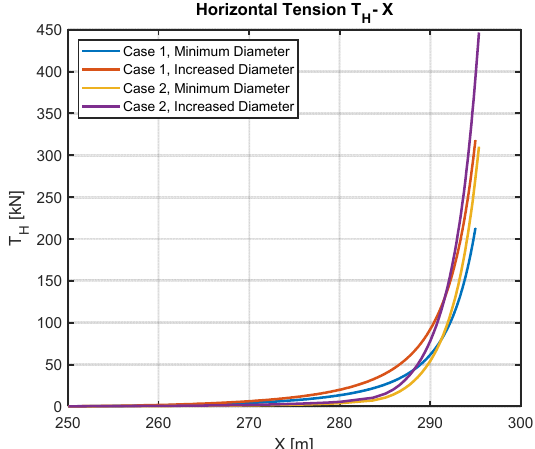
Figure 11. Horizontal mooring tension at the fairlead as a function of horizontal distance from the anchor to the buoy.